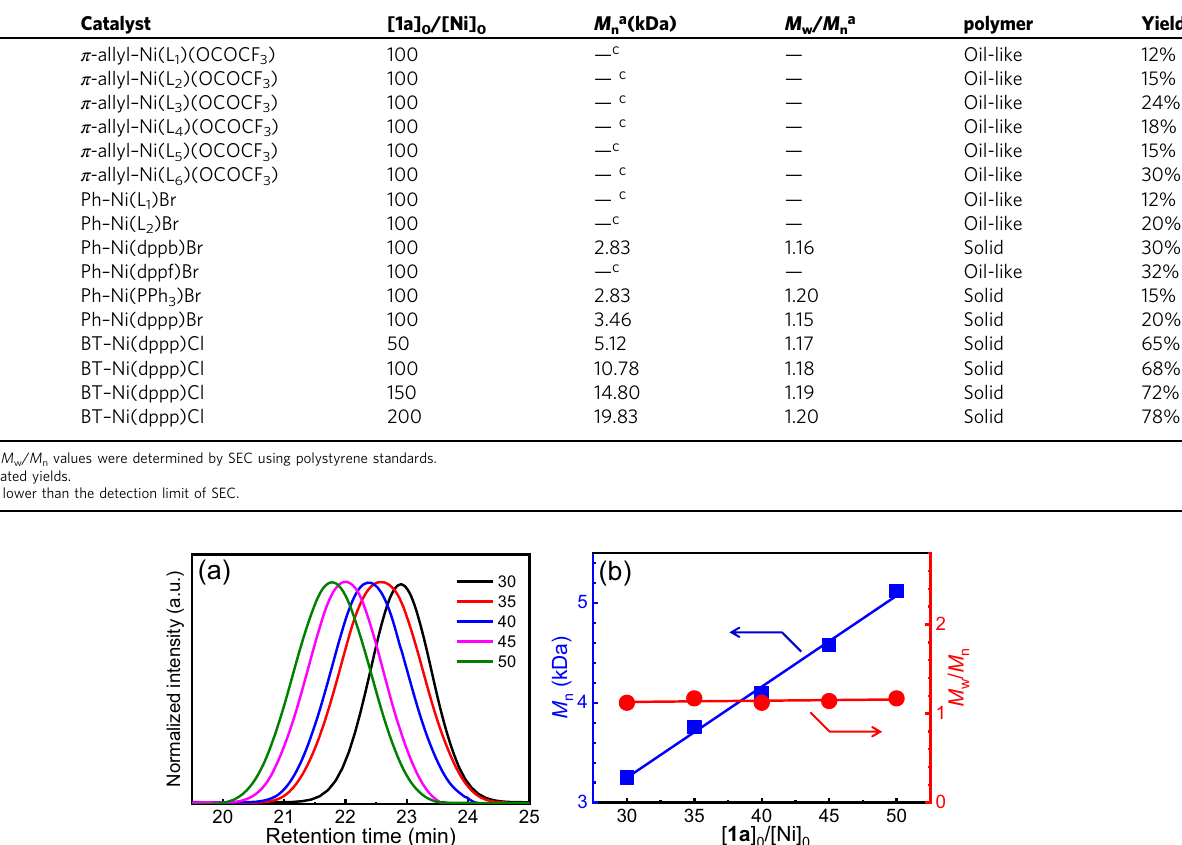
Fig. 2 SEC traces and result analyses. a SEC traces of poly- 1a m s prepared using BT – Ni(dppp)Cl - catalyzed 1a polymerization in different [ 1a ] 0 /[Ni] 0 ratios in THF at 25 °C. b Plots of M n and M w / M n of the poly- 1a m vs. 1a -to-Ni(II)